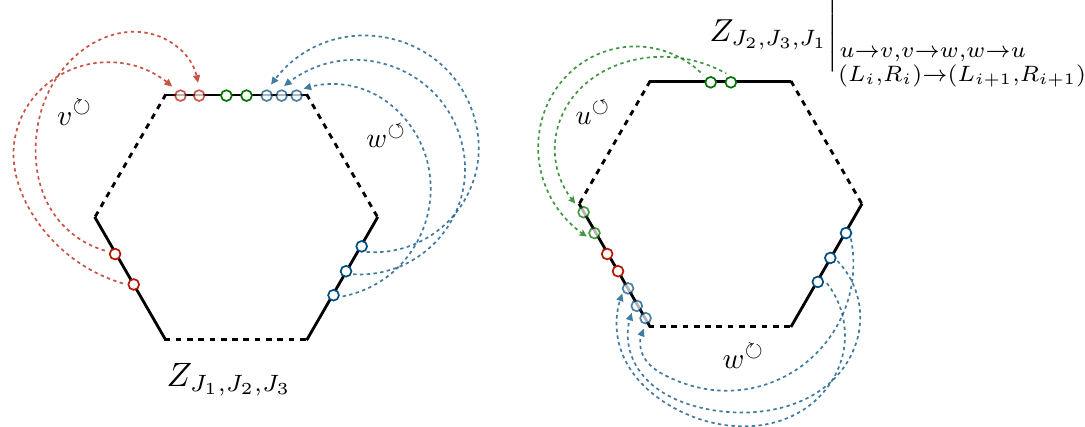
Figure 5 . The N = 4 hexagon form factor [1, 2] from which the hexagon partition function origi- nates is symmetric in its three physical edges, represented here by solid lines. The expression (2.6) is obtained by moving all particles from the v and w edges to the top u edge, left picture. Moving particles to non-adjacent edges of the hexagon correspond to crossing transformations. Alterna- tively, the hexagon form factor could be evaluated through the prescription of the right figure, in which v particles remain physical while w is crossed clockwise and u crossed anticlockwise. The result is equation (2.15). An equivalent statement is that the hexagon form factor is invariant under crossing all particles in the same direction.